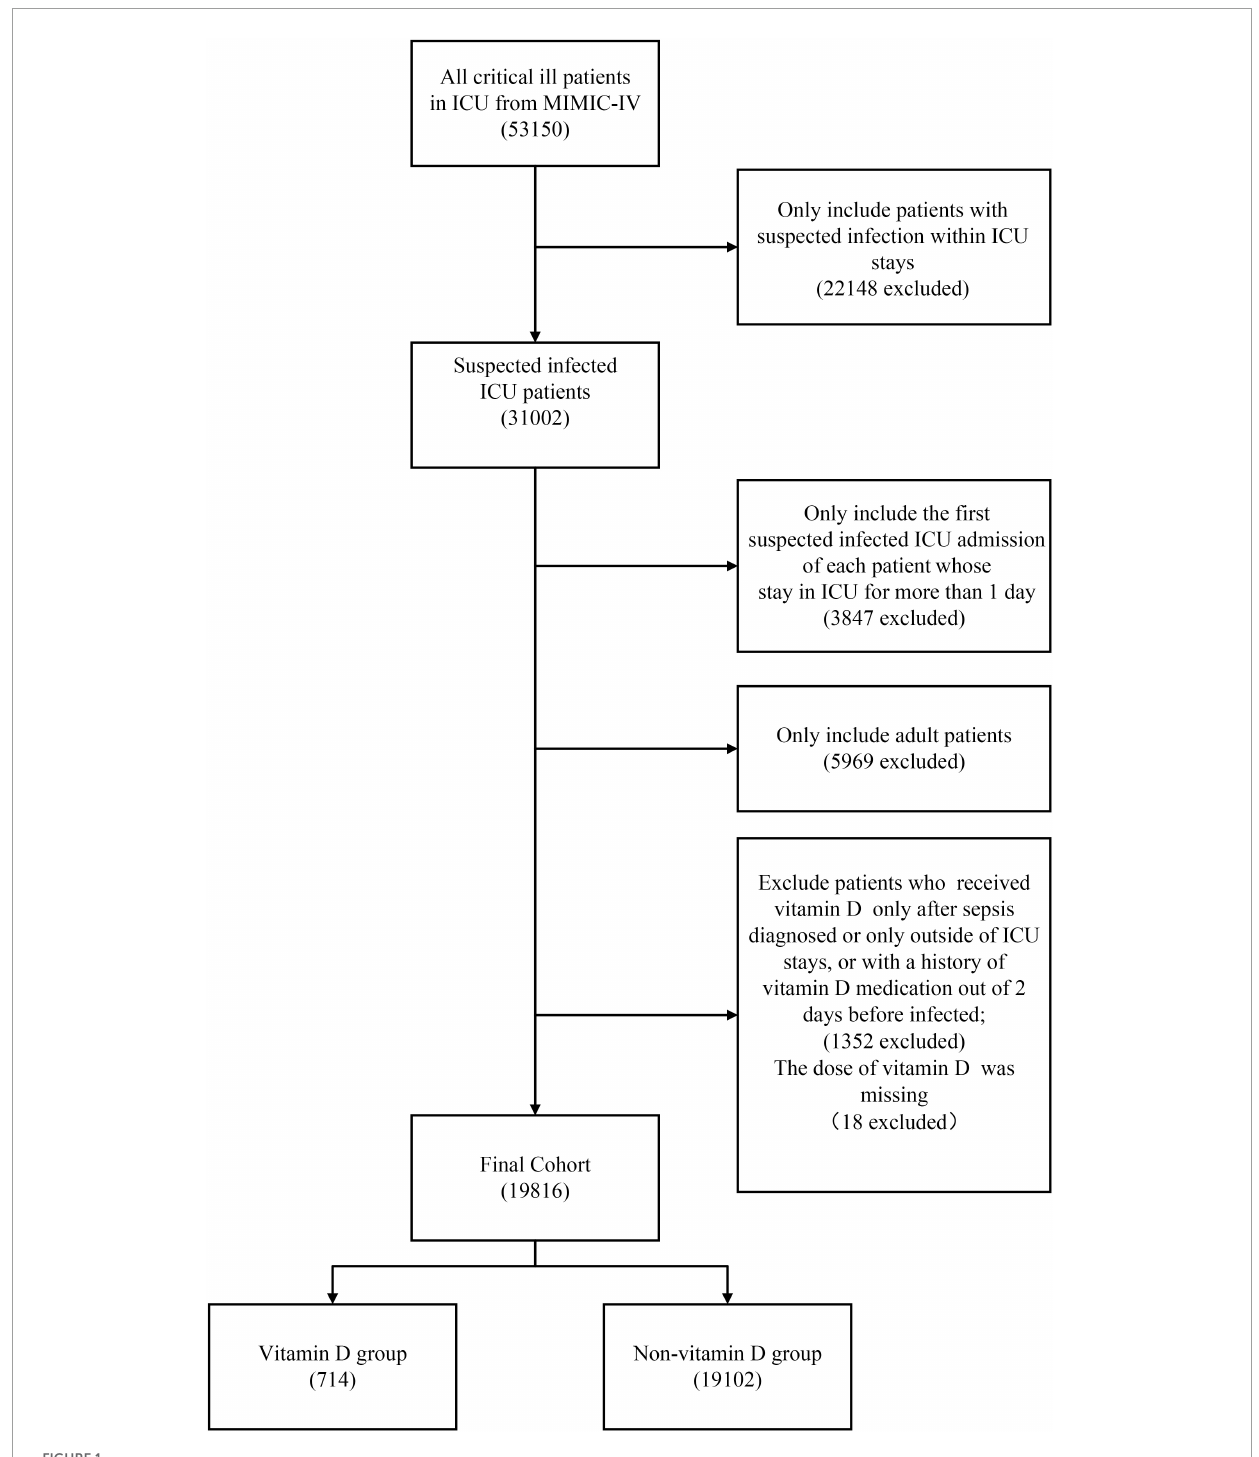
FIGURE1 The flowchart on the selection of the study population.